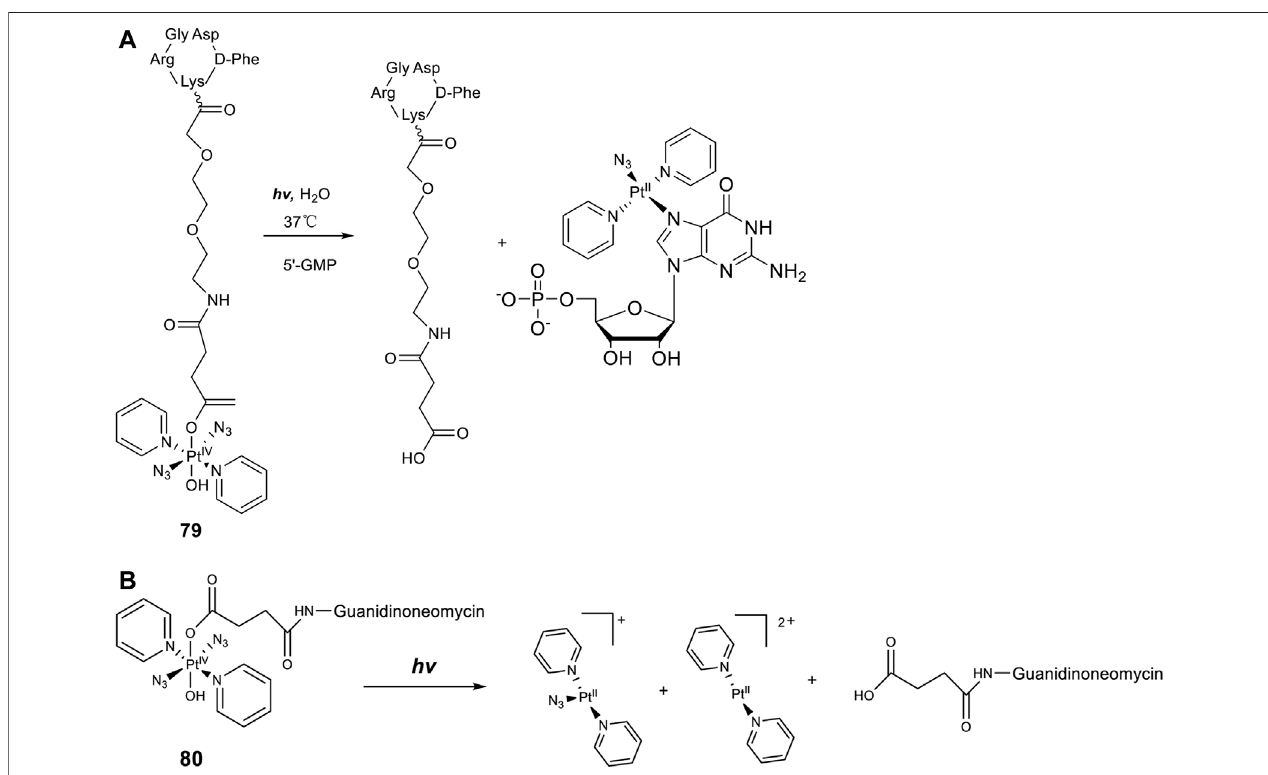
FIGURE 7 | (A) Schematic diagram of the photoreaction of complex 79 with 5 ′ -GMP [adapted from Shaili et al. (2015)]. (B) Schematic representation of the photodissociation process of complex 80 [adapted from Shaili et al. (2015)].